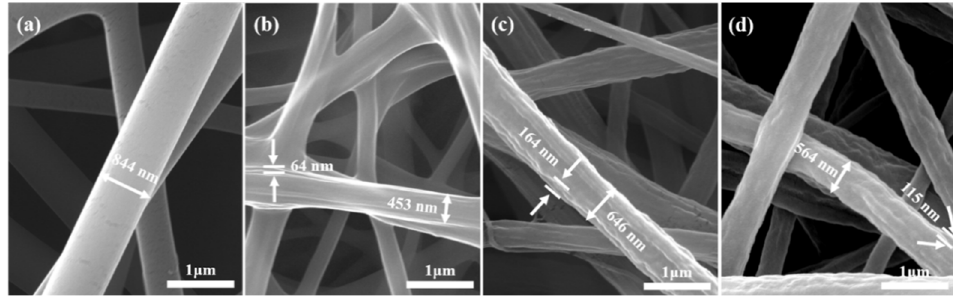
Figure 2. SEM photographs of samples ( a ) V, ( b ) VRT-SD, ( c ) V55-SD, and ( d ) V95-SD, with nanofiber diameters and surface-roughness values as indicated.